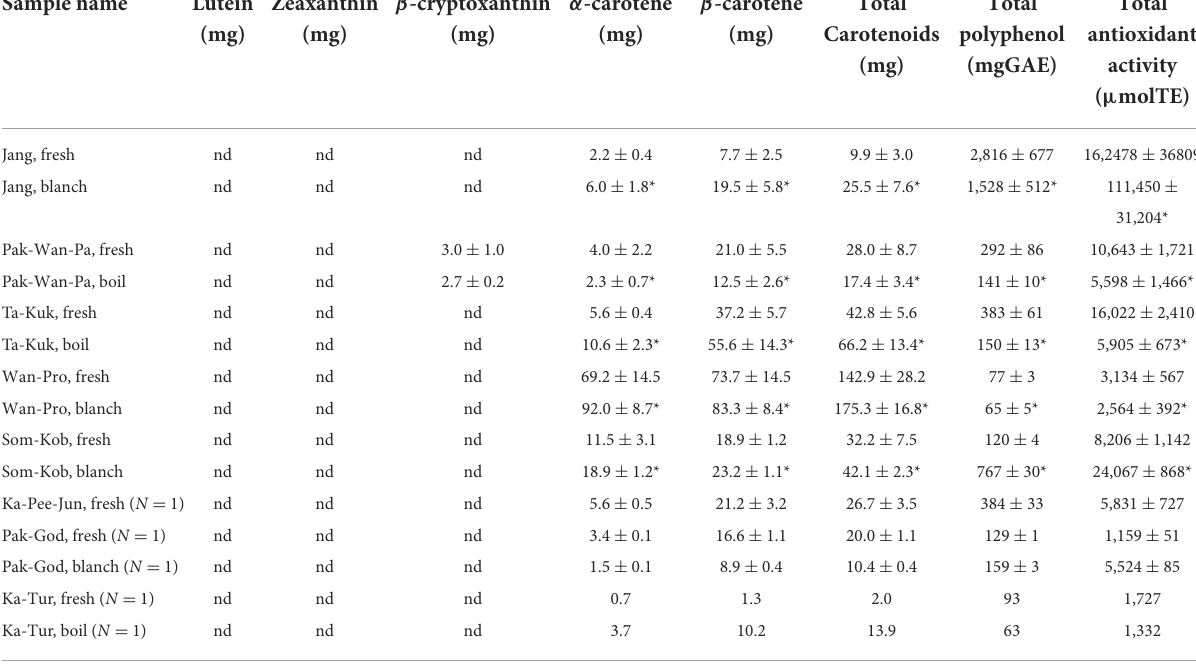
TABLE 4 Bioactive compounds and antioxidant activities of the indigenous plants (per 100g fresh weight, N =